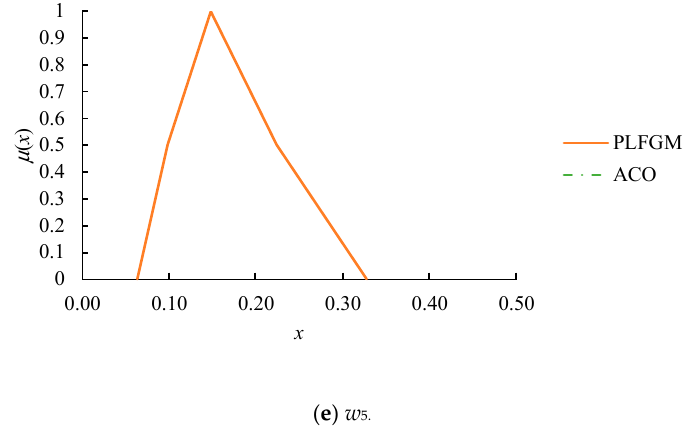
Figure 9. Fuzzy priorities estimated using PLFGM ( a ) w 1 ; ( b ) w 2 ; ( c ) w 3 ; ( d ) w 4 ; ( e ) w 5.